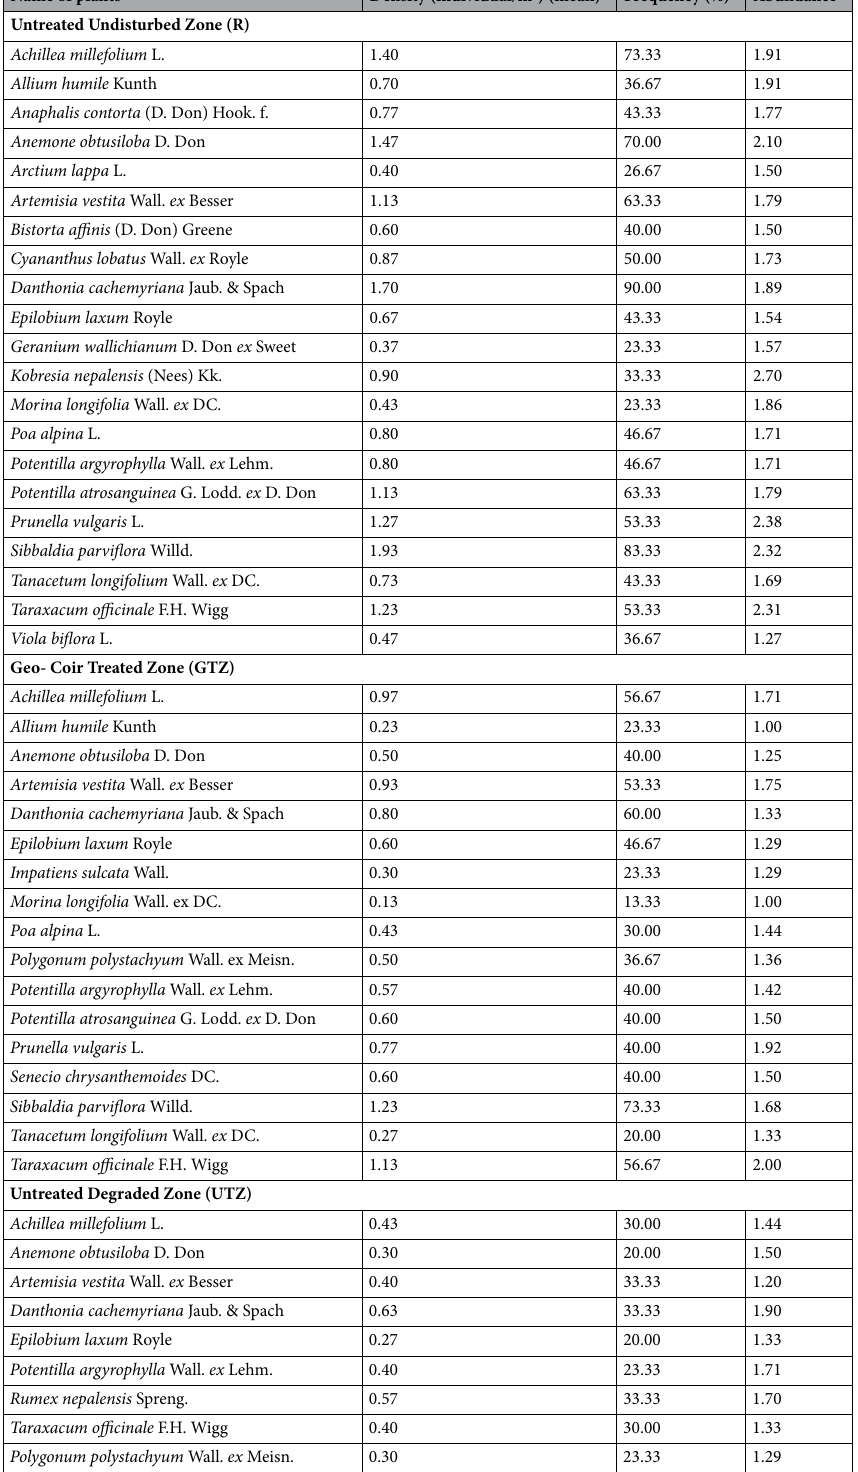
Table 3. Dominant herbs (density/m 2 ) frequency (%) and abundance among comparison in Untreated Undisturbed Zone (R), Geo-Coir Treated Zone (GTZ), and Untreated Degraded Zone (UTZ) of the Dayara